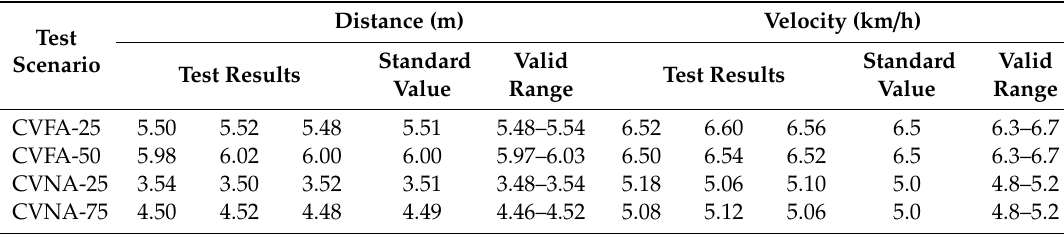
Table 5. Test of the walking distance and speed of the dummy target (with SUV2).